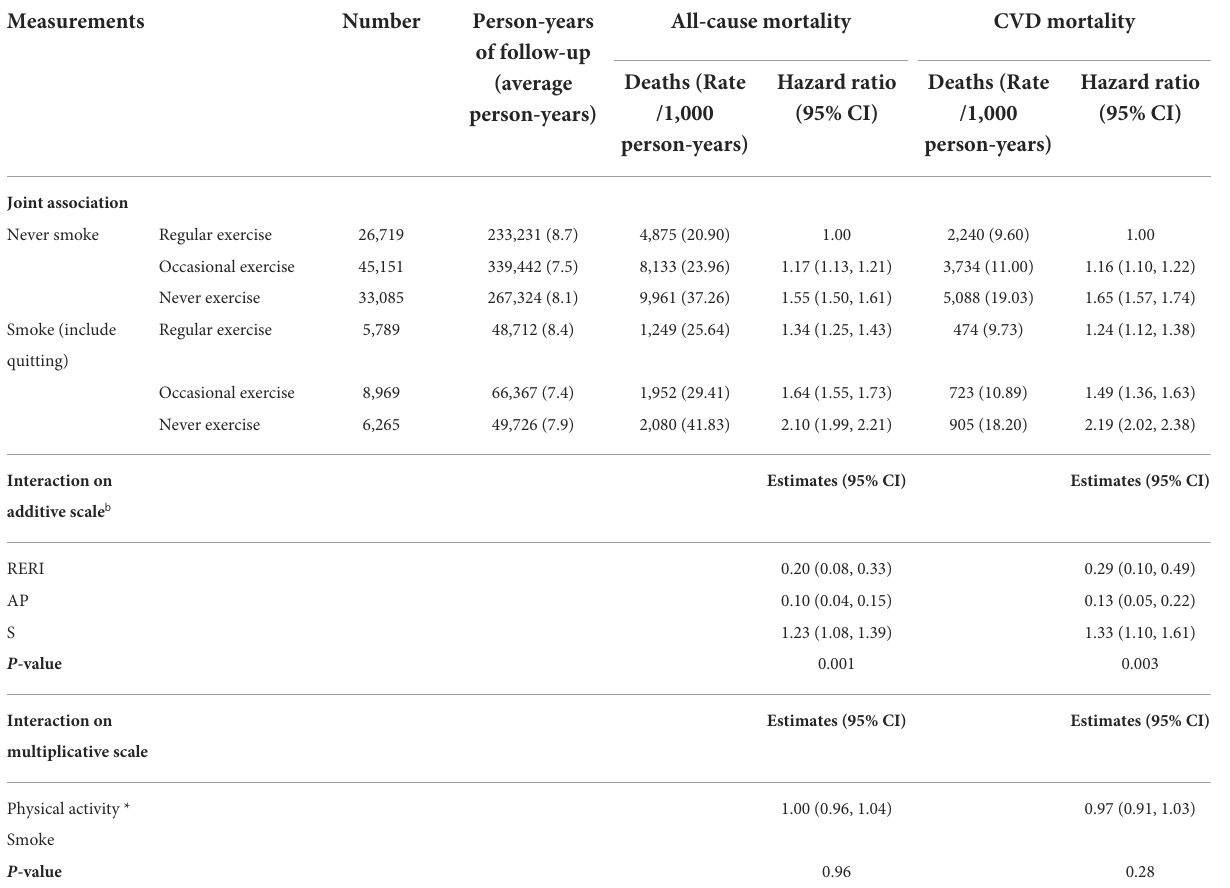
TABLE 3 Joint association of smoking and physical activity with mortality risk a